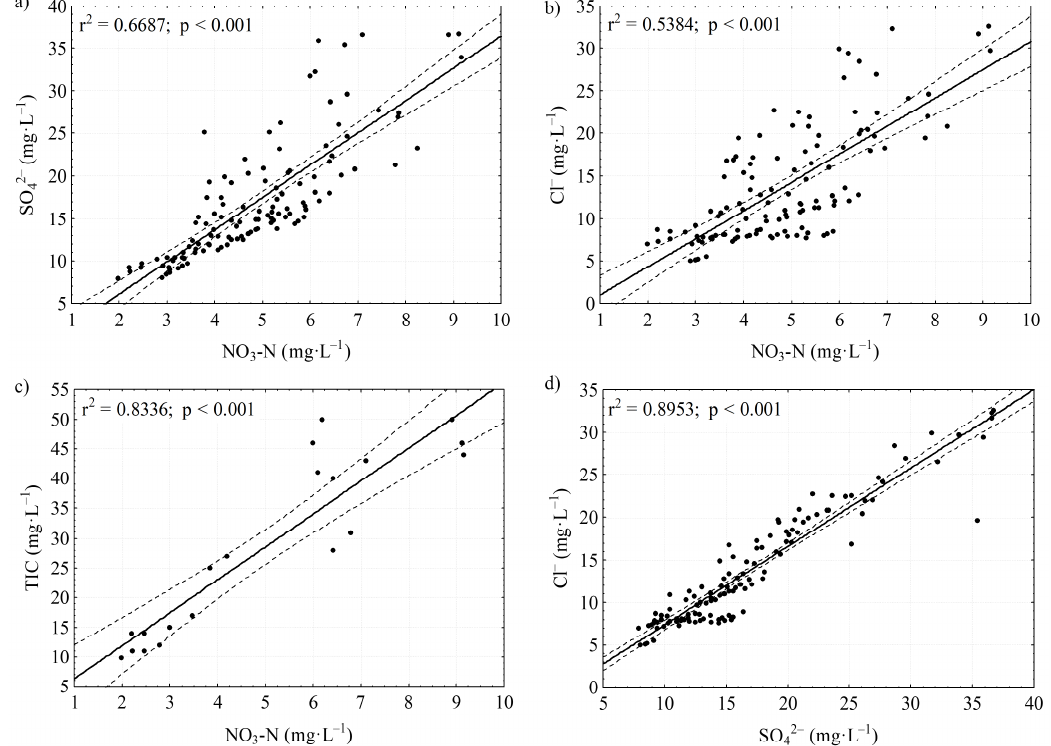
Figure 4. Linear correlations between ( a ) sulphate (SO 42 − ) and nitrate (NO 3 -N); ( b ) chlorine (Cl − ) and nitrate (NO 3 -N); ( c ) total inorganic carbon (TIC) and nitrate (NO 3 -N); ( d ) chlorine (Cl − ) and sulphate (SO 42 − ) concentrations measured from inlets and outlets of the wetlands. Dashed line represents 95% confidence interval.